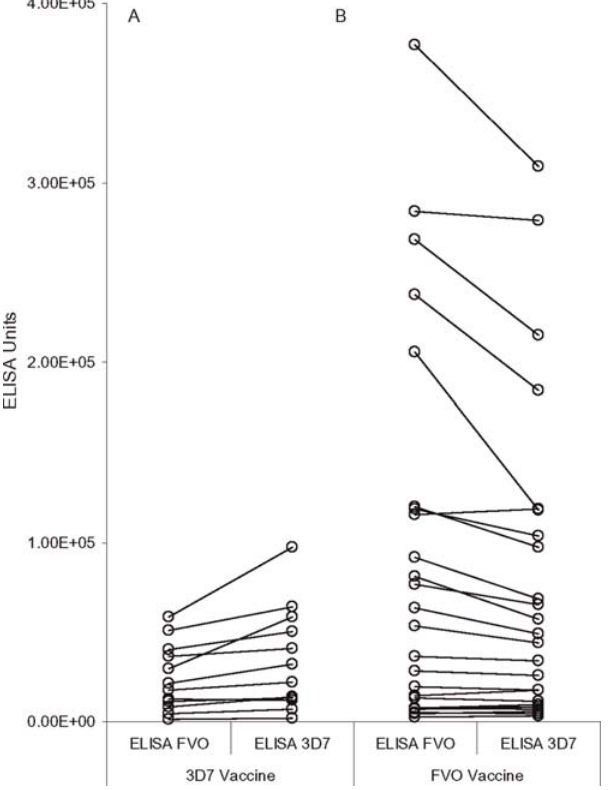
Figure 1. Individual value plots showing strain-specific Ab responses by ELISA for vaccine recipients. Responses are grouped by vaccine strain received and then by the Ag strain use for ELISA. Panel A includes all 3D7 strain vaccine recipients in the trial. Panel B includes all FVO strain vaccine recipients in the trial. Connect lines join each individual animal’s ELISA Ab response measured with the FVO Ag to that measured with the 3D7 Ag. Both Ag were expressed in baculovirus.